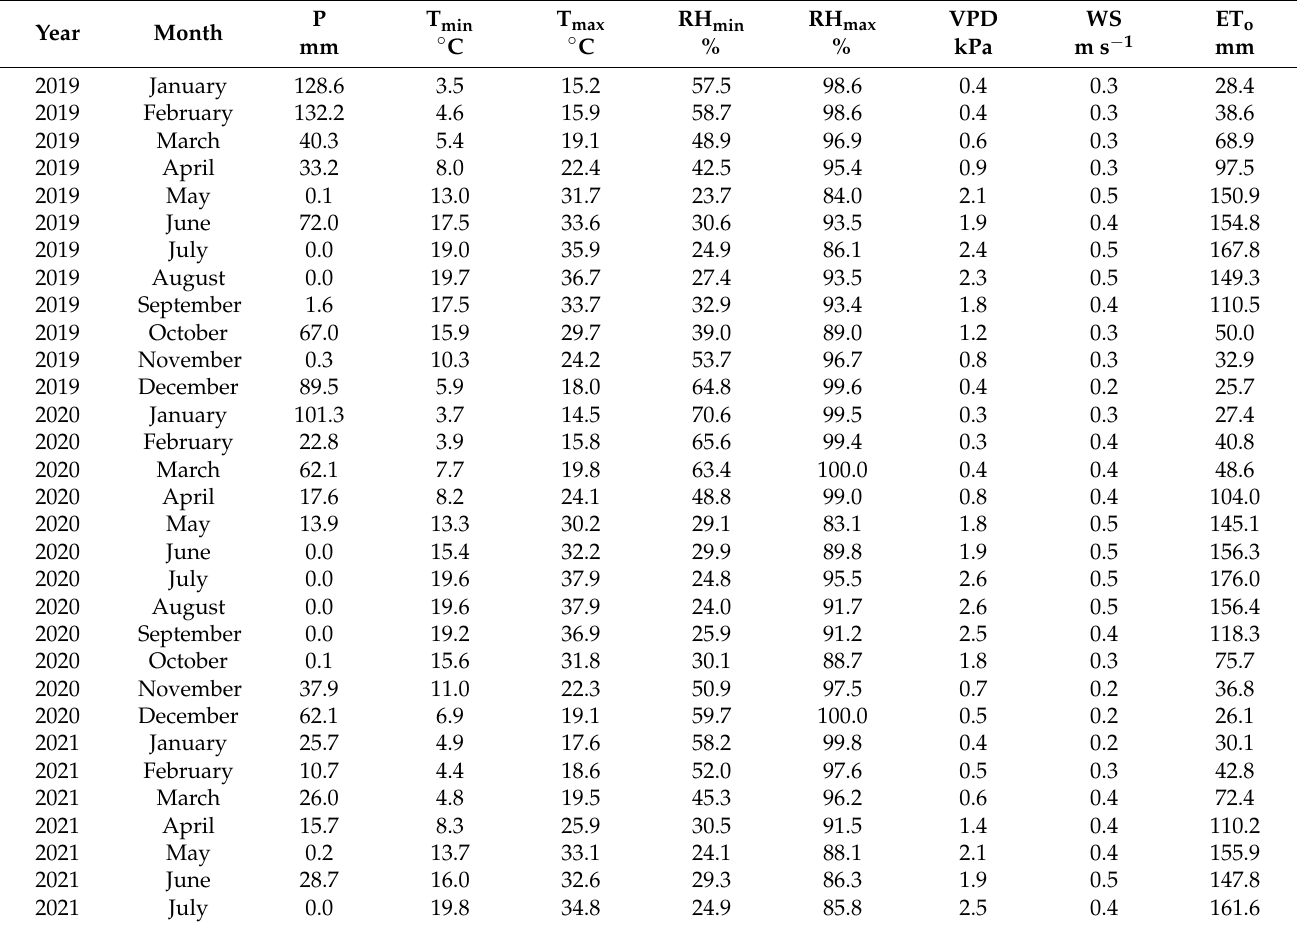
Table A1. Monthly total precipitation (P), average daily minimum and maximum temperature (T min